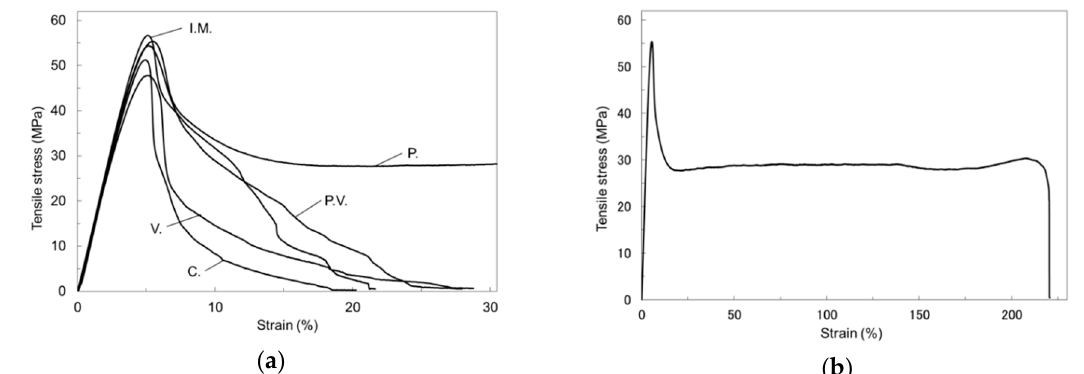
Figure 5. ( a ) Representative stress–strain curves of the tensile test for five non-immersed test pieces. ( b ) The full curve of test piece P.